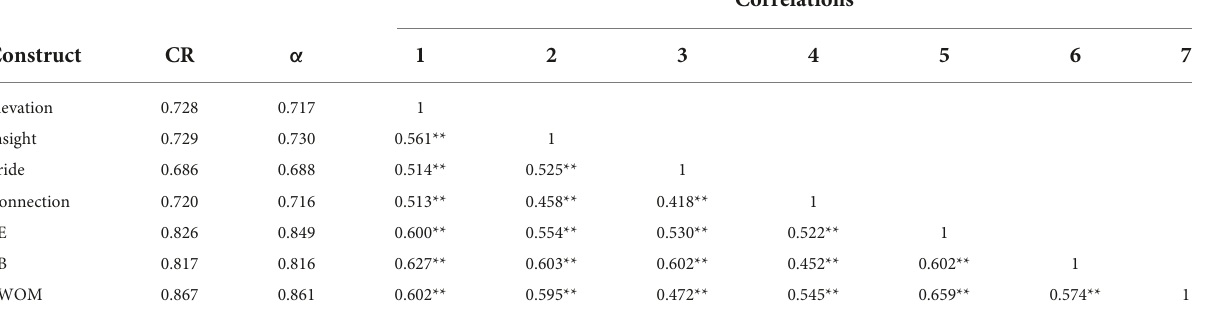
TABLE 7 Construct reliability (CR), Cronbach’s alpha, and